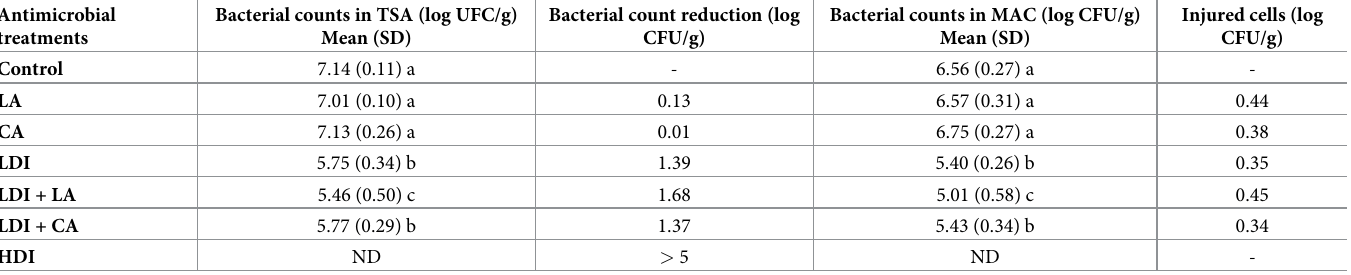
Results are expressed as mean (SD); n = 30 per